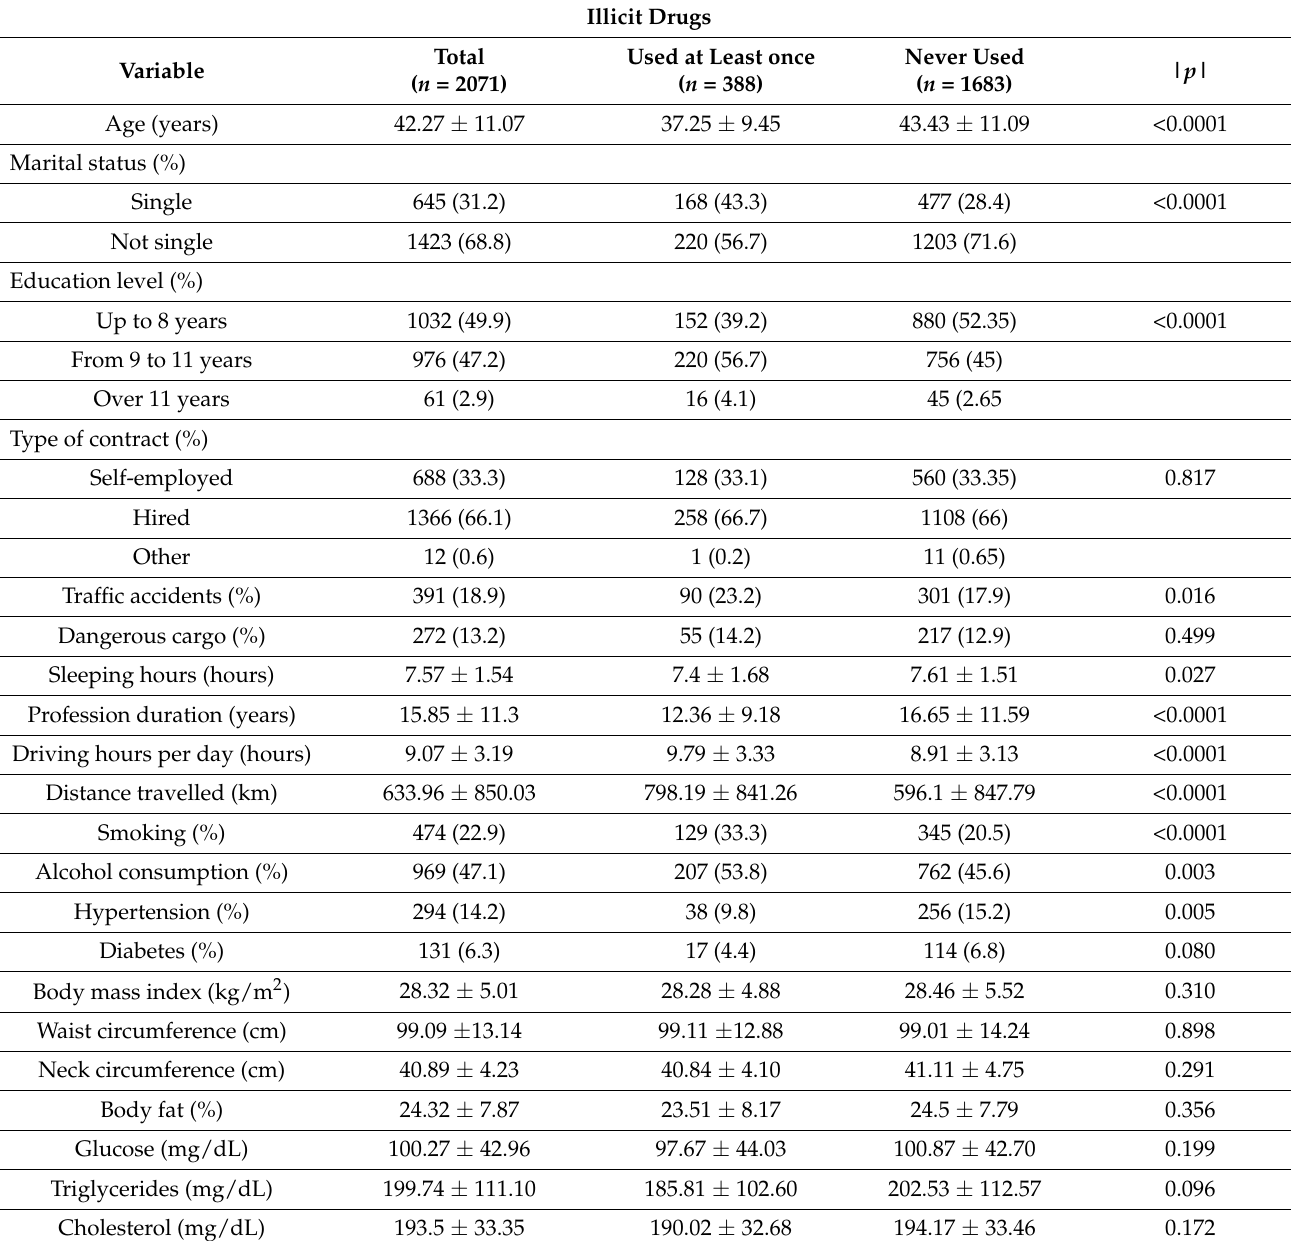
Table 1. Sociodemographic data, occupational data, and clinical and laboratory data collected from 2071 truck drivers who traveled through the state of S ã o Paulo between 2010 and 2016, classified according to the self-report of consumption of illicit